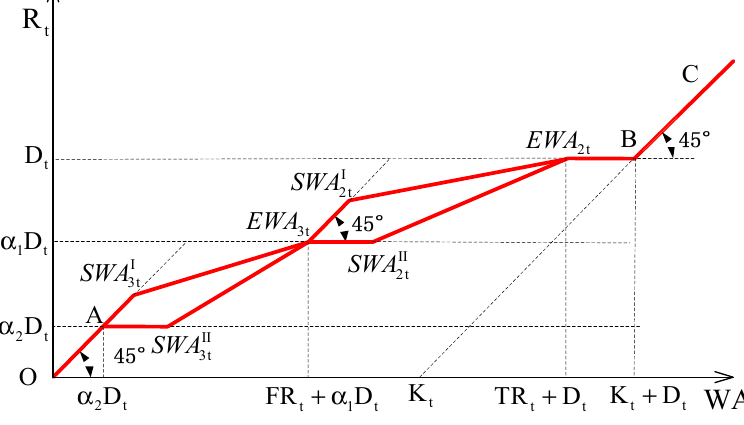
Figure 3. The derived optimal hedging policy for Rule 1.